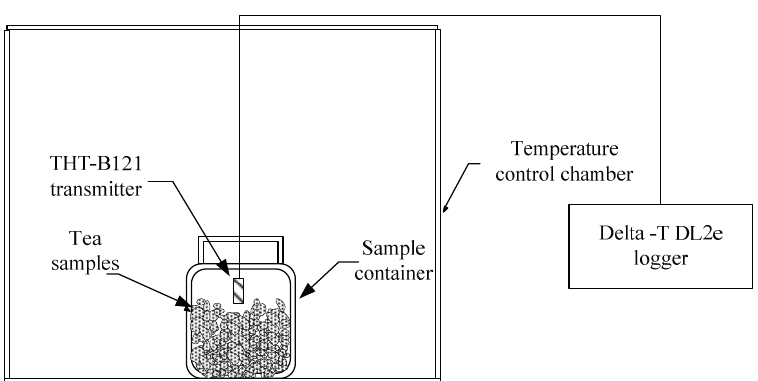
Figure 1. The diagram of the experimental